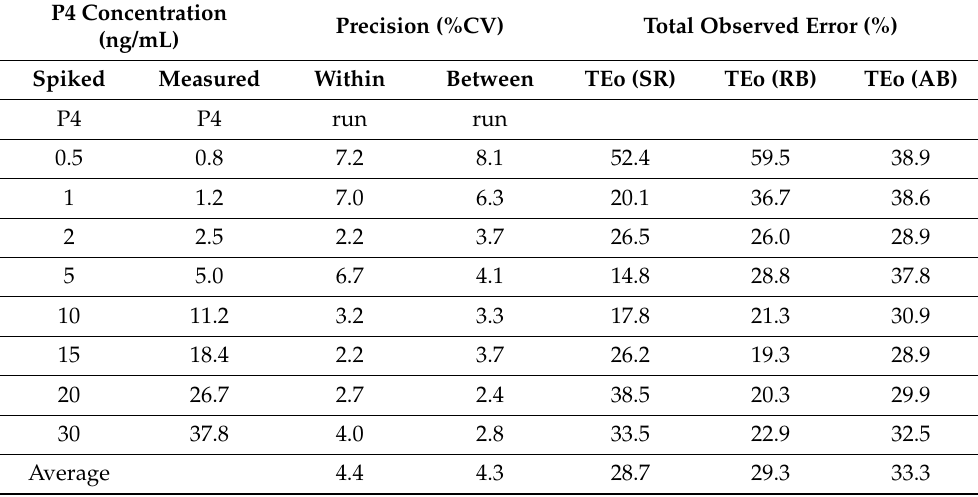
Table 1. IMMULITE ® 2000 XPi P4 assay precision and total observed error results for readable range in spiked sheep